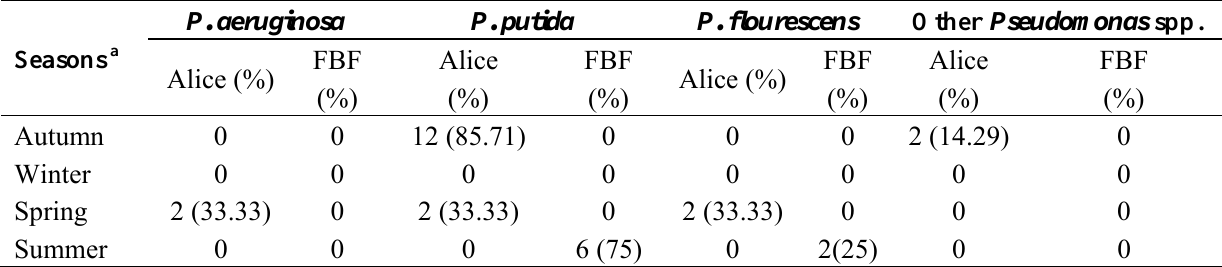
Table 2. Prevalence of Pseudomonas species in freshwater